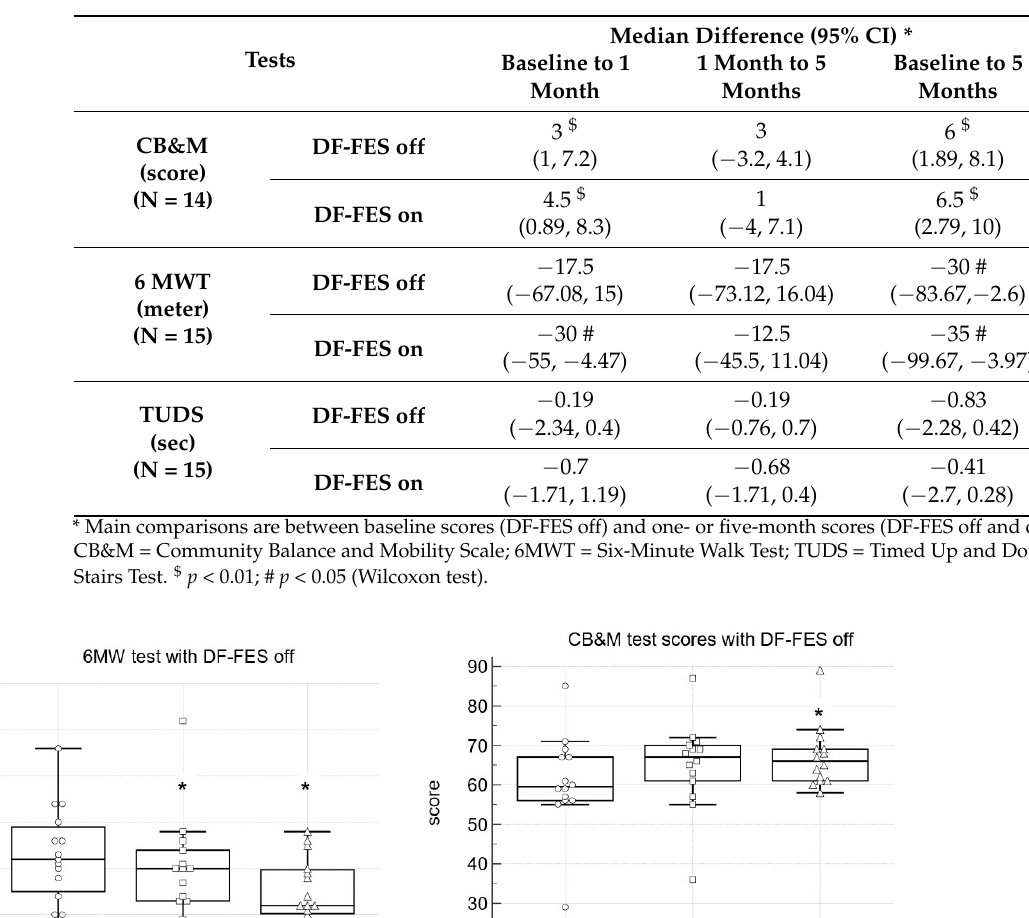
Table 2. Motor function scores—median difference.